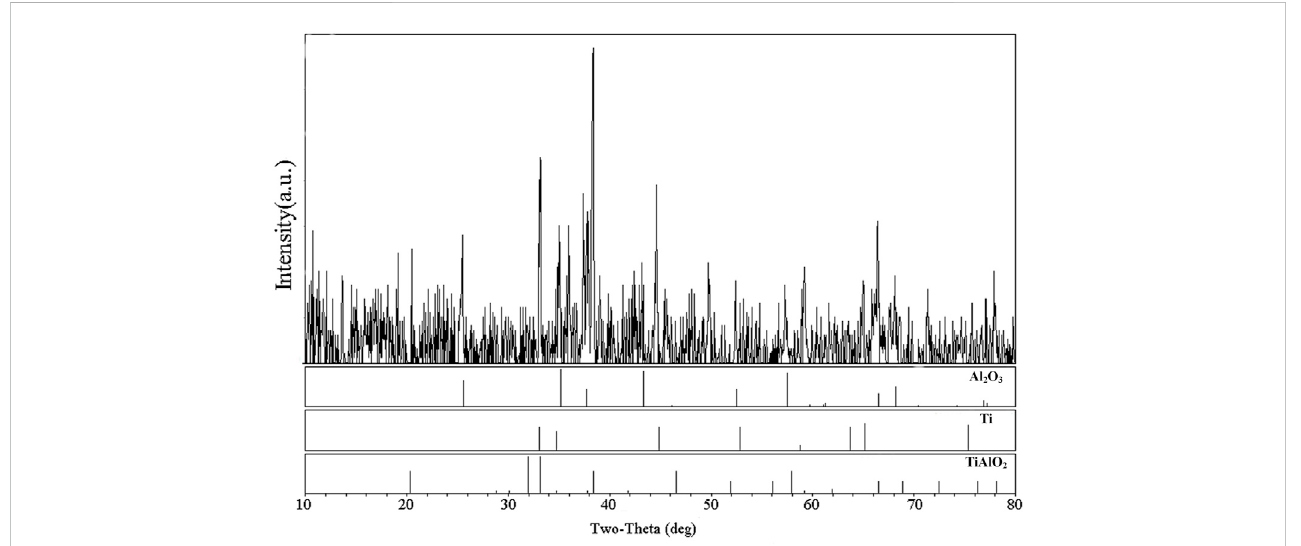
FIGURE 4 The XRD of the aluminum and titanium dioxide mixture materials after combustion.